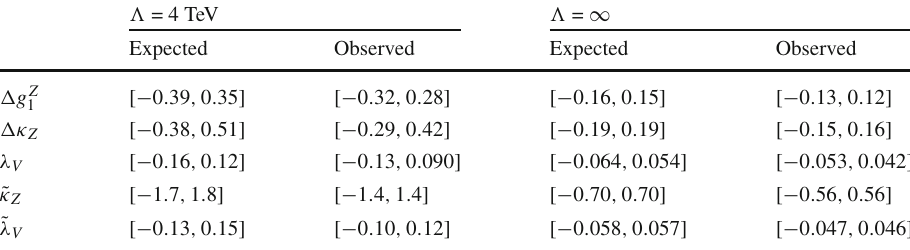
(cid:19) = 4 TeV (cid:19) =